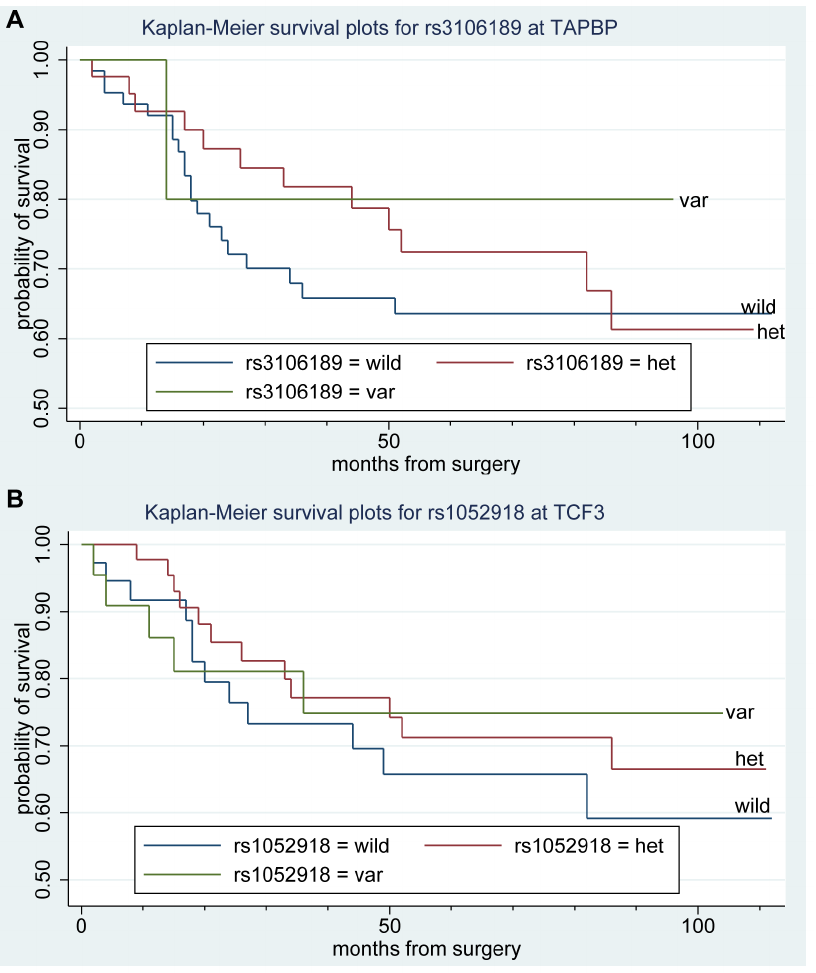
Figure 2. Colorectal cancer overall survival in relationship to SNPs. (A) Kaplan-Meier plot for rs3106189 localized to the 5 9 UTR of TAPBP. (B) Kaplan-Meier plot for rs1052918 localized to the 3 9 UTR of the TCF3. Y-axis, CRC survival probability; X-axis, months from surgery. Blue lines are homozygous wildtype (wild), green are homozygous variant (var), red are heterozygous variant (het).